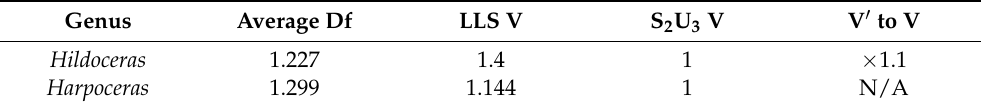
Table 1. Fractal data for hildoceratids based on average fractal dimensions of Hildoceras and Harpoceras from File S1 in the Supplementary Materials of Marriott and Chamberlain [11], LLS conversion value (V), and secondary (S 3 U 3 ) conversion value. Estimated fractal range and conversion values determined for Esericeras by the authors of this paper in the same methods laid out by Marriott and Chamberlain